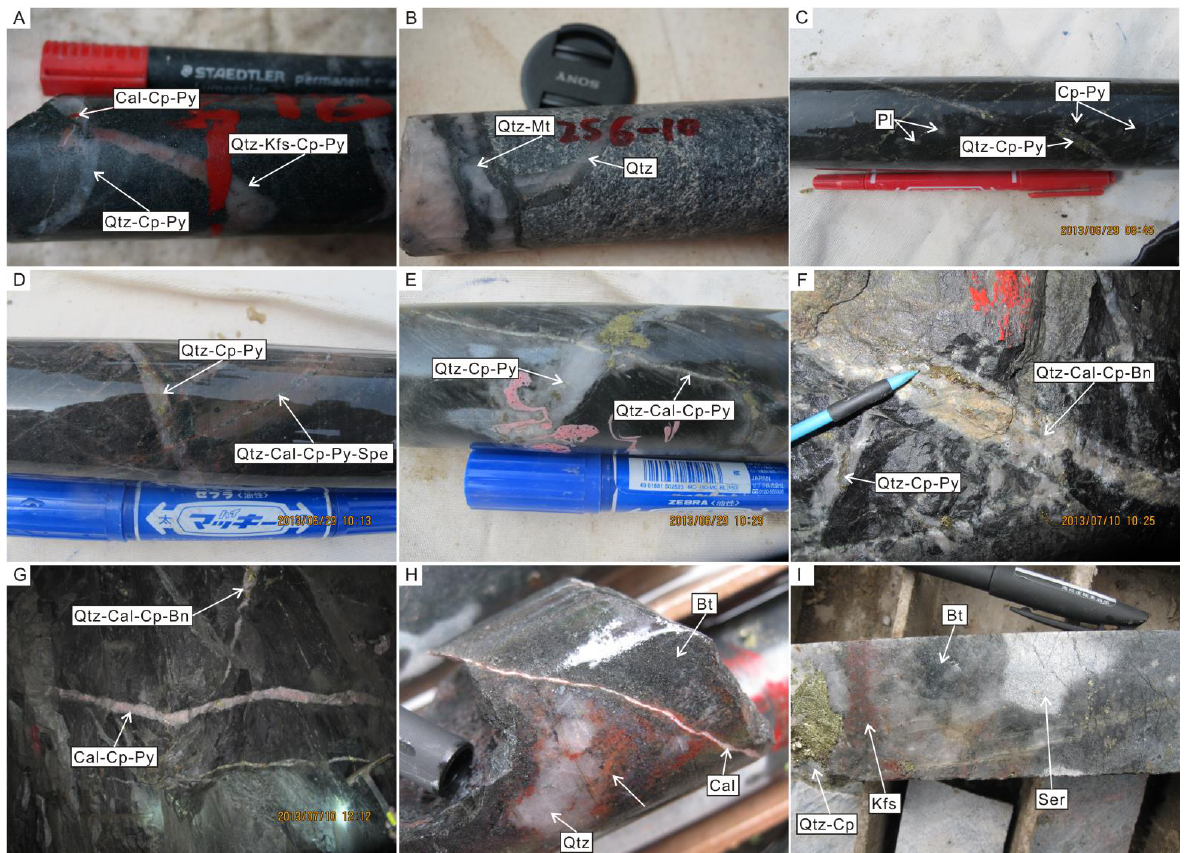
Figure 5. Vein types and their relationships in Tongkuangyu deposit. ( A ) Quartz–chalcopyrite–pyrite vein cutting quartz–K feldspar–chalcopyrite–pyrite vein, all crosscut by later calcite–chalcopyrite– pyrite vein (Sample 263–14, No. 263 drilling of No. V orebody). ( B ) Late quartz–magnetite vein cutting barren quartz vein (Sample 256–10, No. 256 drilling of No. V orebody). ( C ) Quartz–chalcopyrite– pyrite vein cutting veinlet-disseminated chalcopyrite ± pyrite in granodiorite porphyry (Sample 0629, No. 041 drilling of No. IV orebody). ( D ) Quartz–chalcopyrite–pyrite vein crosscut by